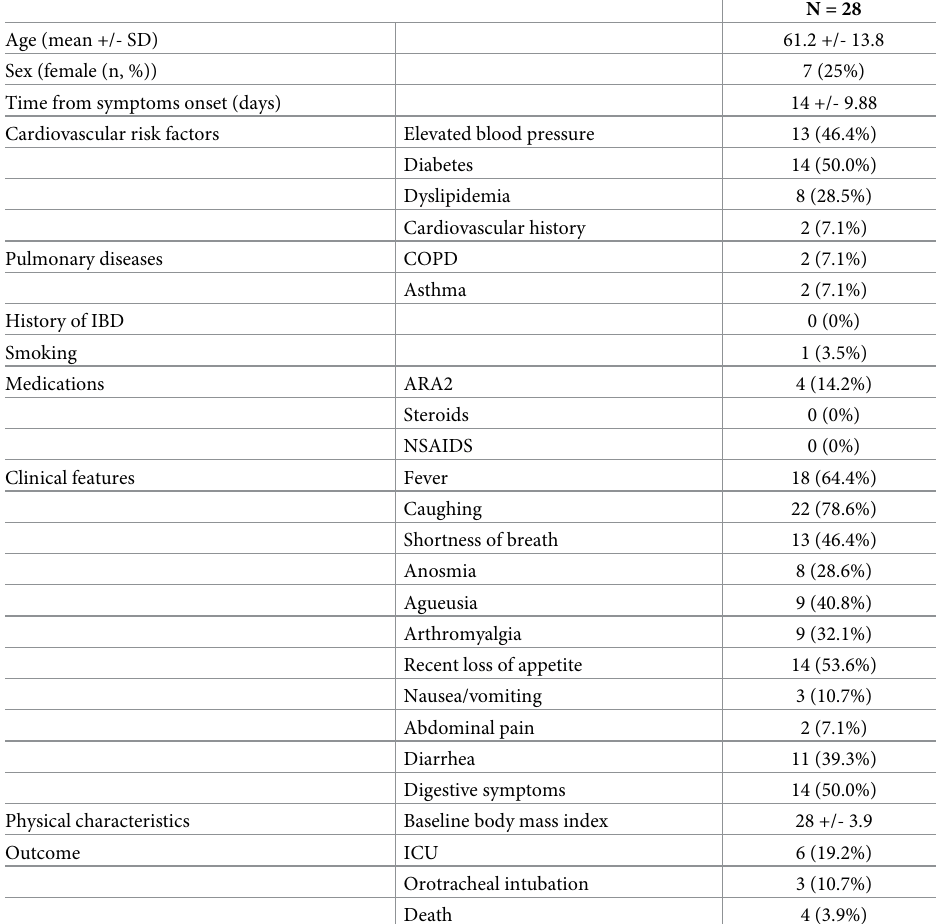
Table 1. Main COVID19-patients characteristics.